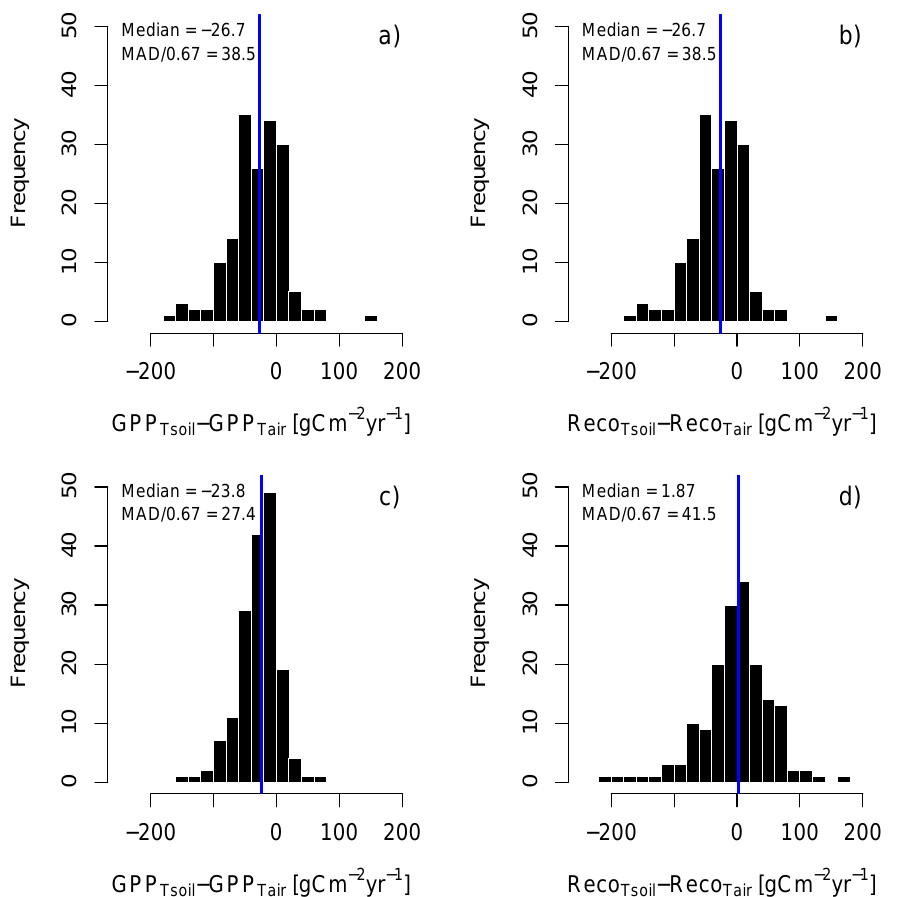
Fig. 8. Difference in annual estimates using the Reichstein et al. (2005) method (a) , (b) and the Lasslop et al. (2010) approach (c) , (d) , blue vertical line indicates the median value, MAD is the median absolute deviation. Note that (a) and (b) are identical due to the